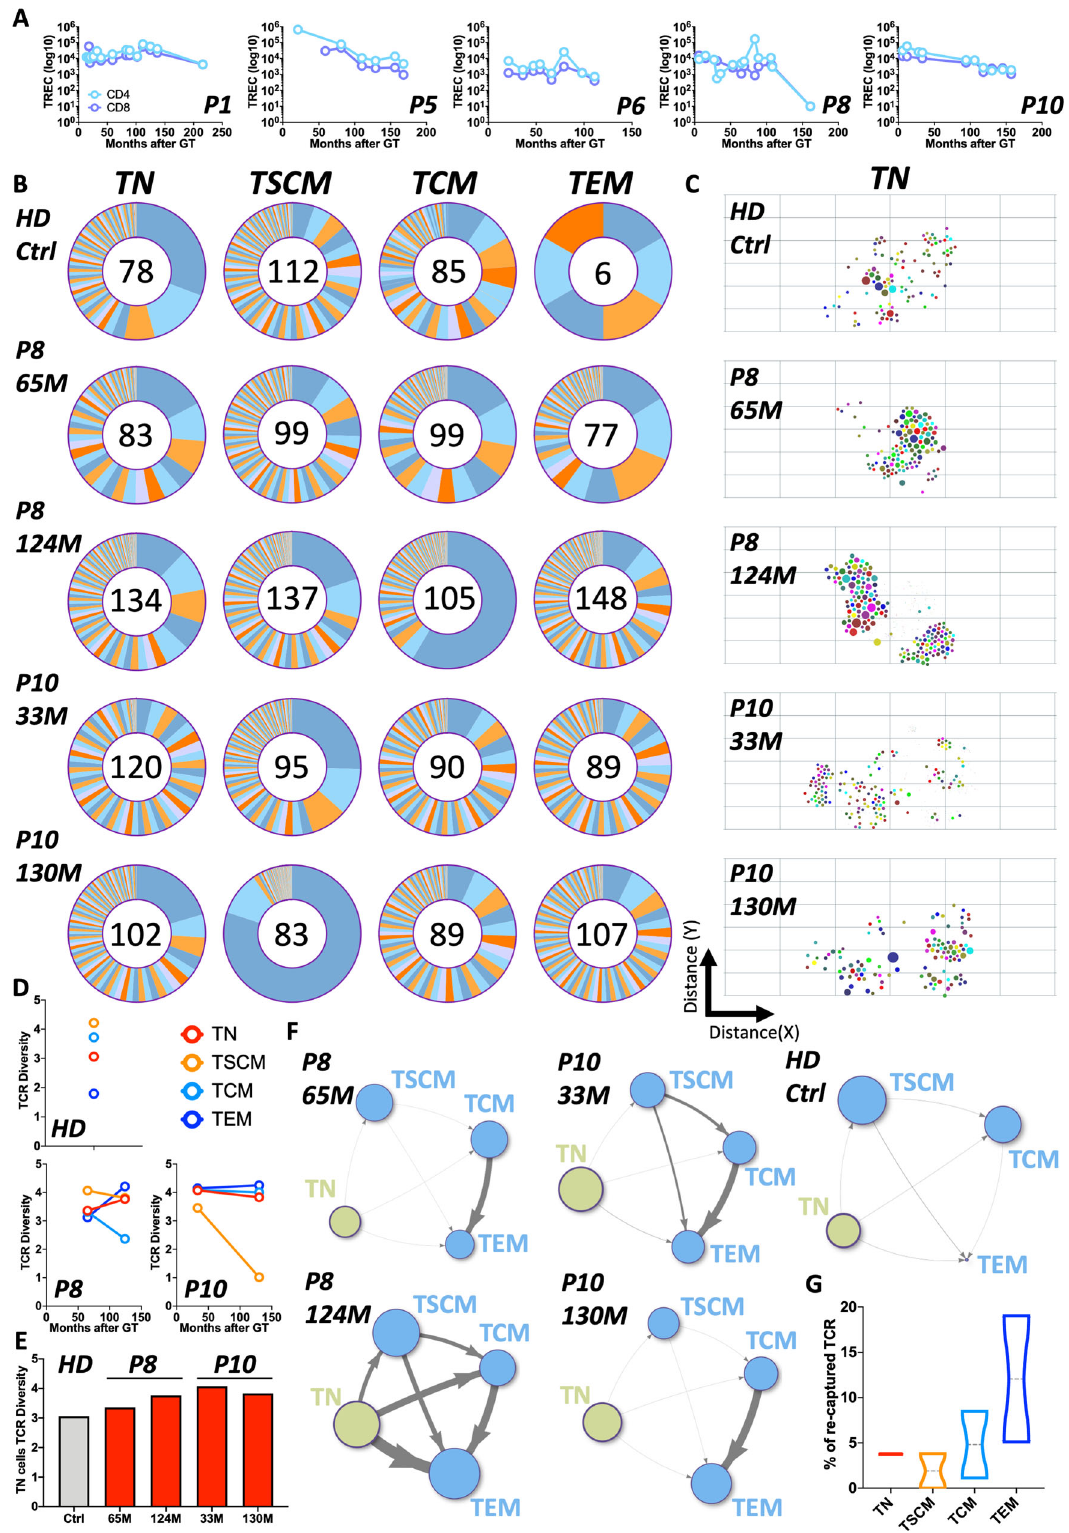
these loci were not preferentially targeted upon CD34 + cells transduction 20,21 and because we do not have evidence for aberrant clonal selection, we can speculate that this could be the result of a physiological positive-selection for clones carrying the vector in genomic locations allowing for optimal transgene expression upon T cell